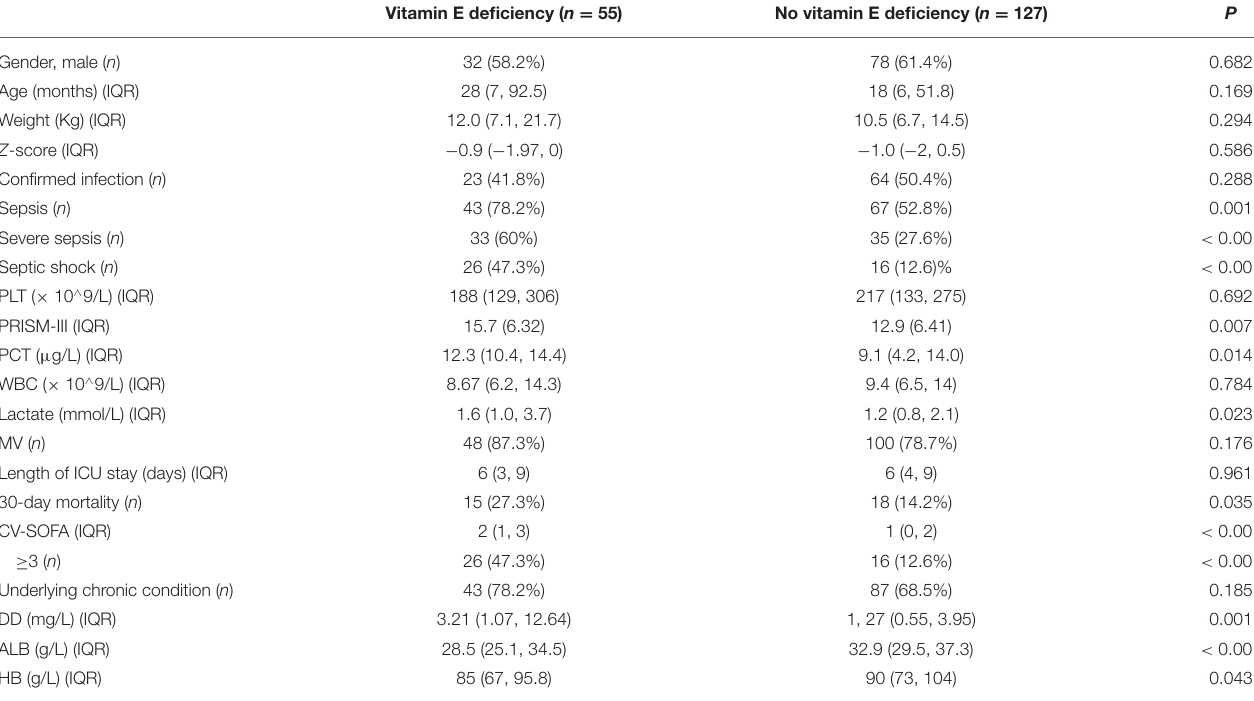
TABLE 2 | Clinical features of children with confirmed or suspected infection stratified by vitamin E status. Vitamin E deficiency ( n = 55)